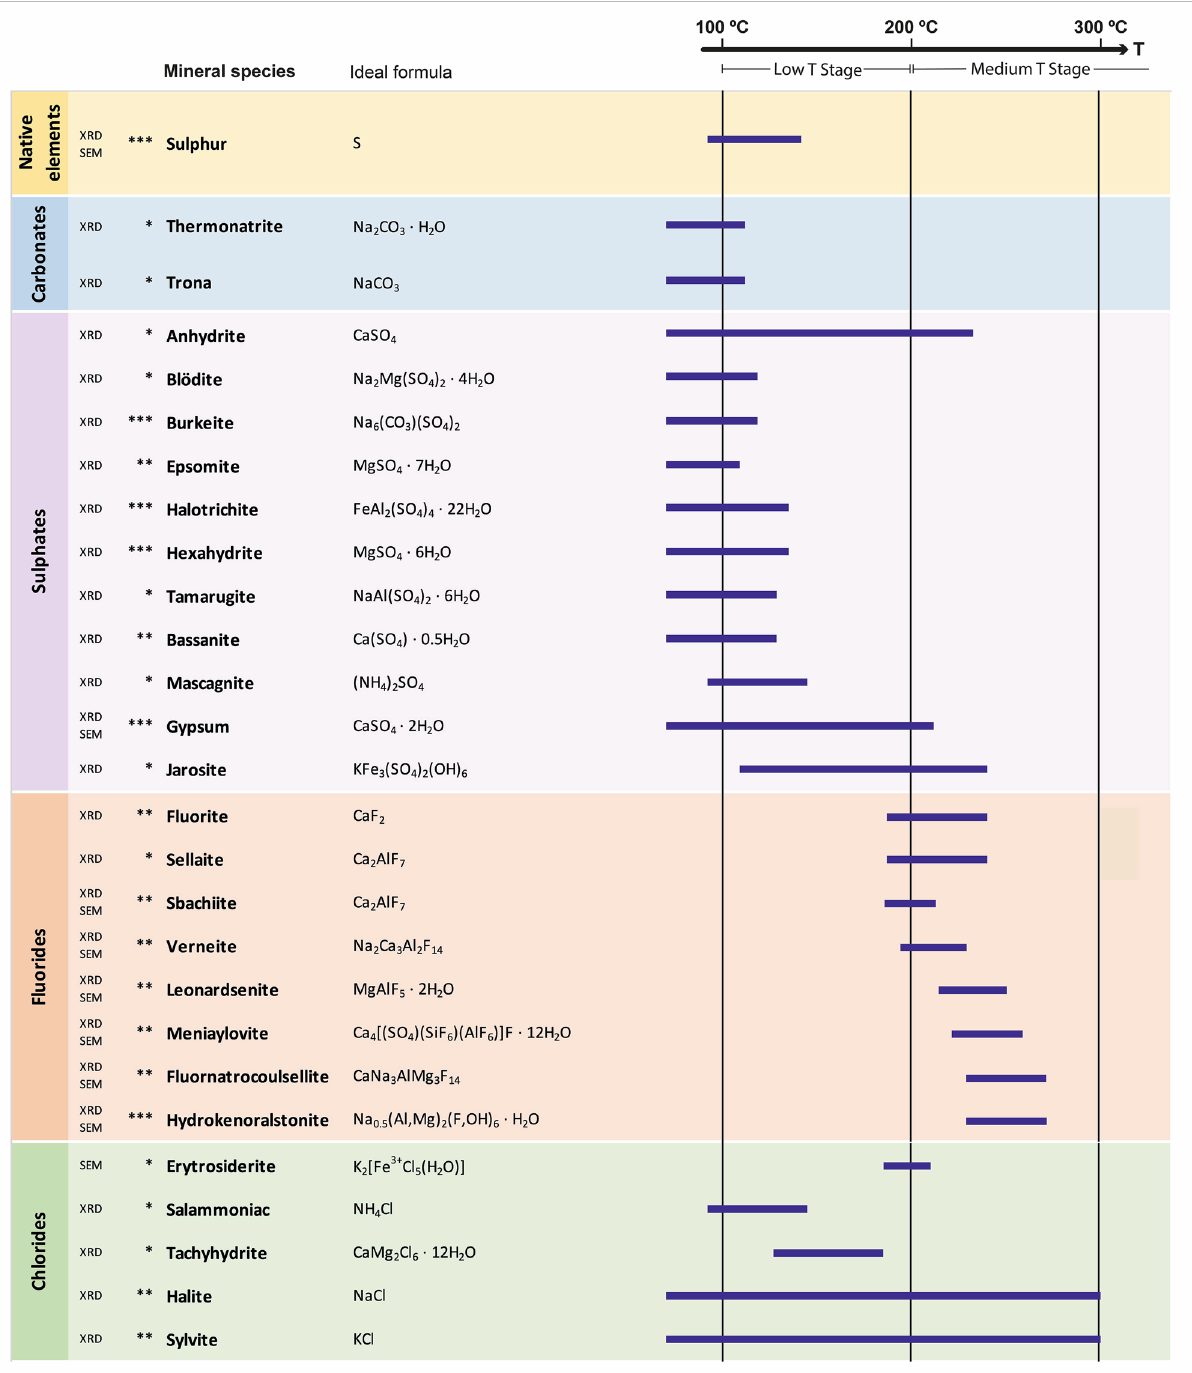
Figure 5. Mineral paragenesis of the Tajogaite fumaroles in relation with temperature. Occurrence of mineral phases: *rare; **common; ***very common. It is also indicated whether species identification was carried out through powder X-Ray diffraction (XRD) or FE–SEM–EDS